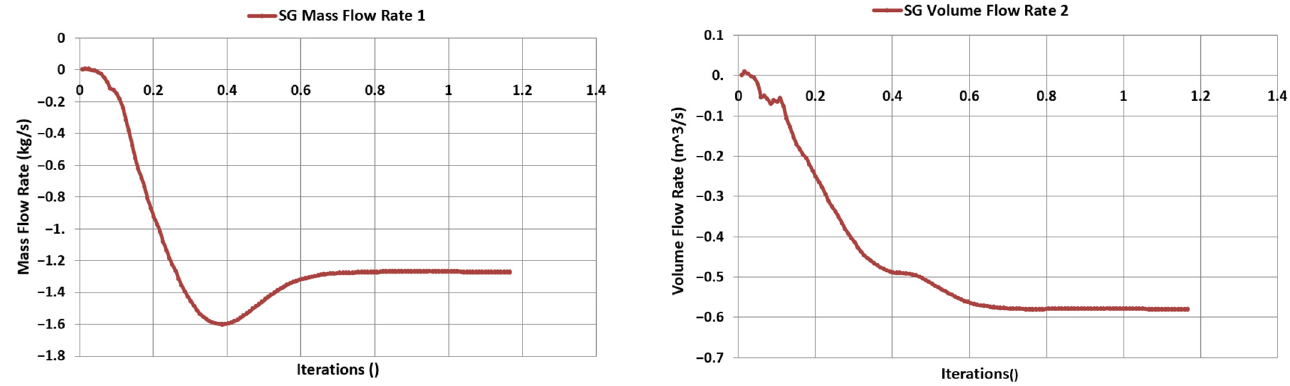
Figure 15. Mass and volume flow rate of turbine intake for Figure 9.